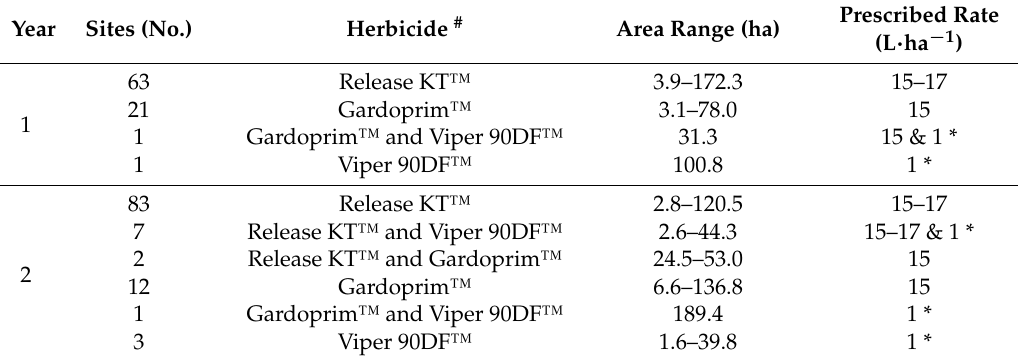
Table 2. Upper Rangitaiki catchment herbicide application sites, area ranges, and prescribed application rate summaries, for Year 1 and Year 2.